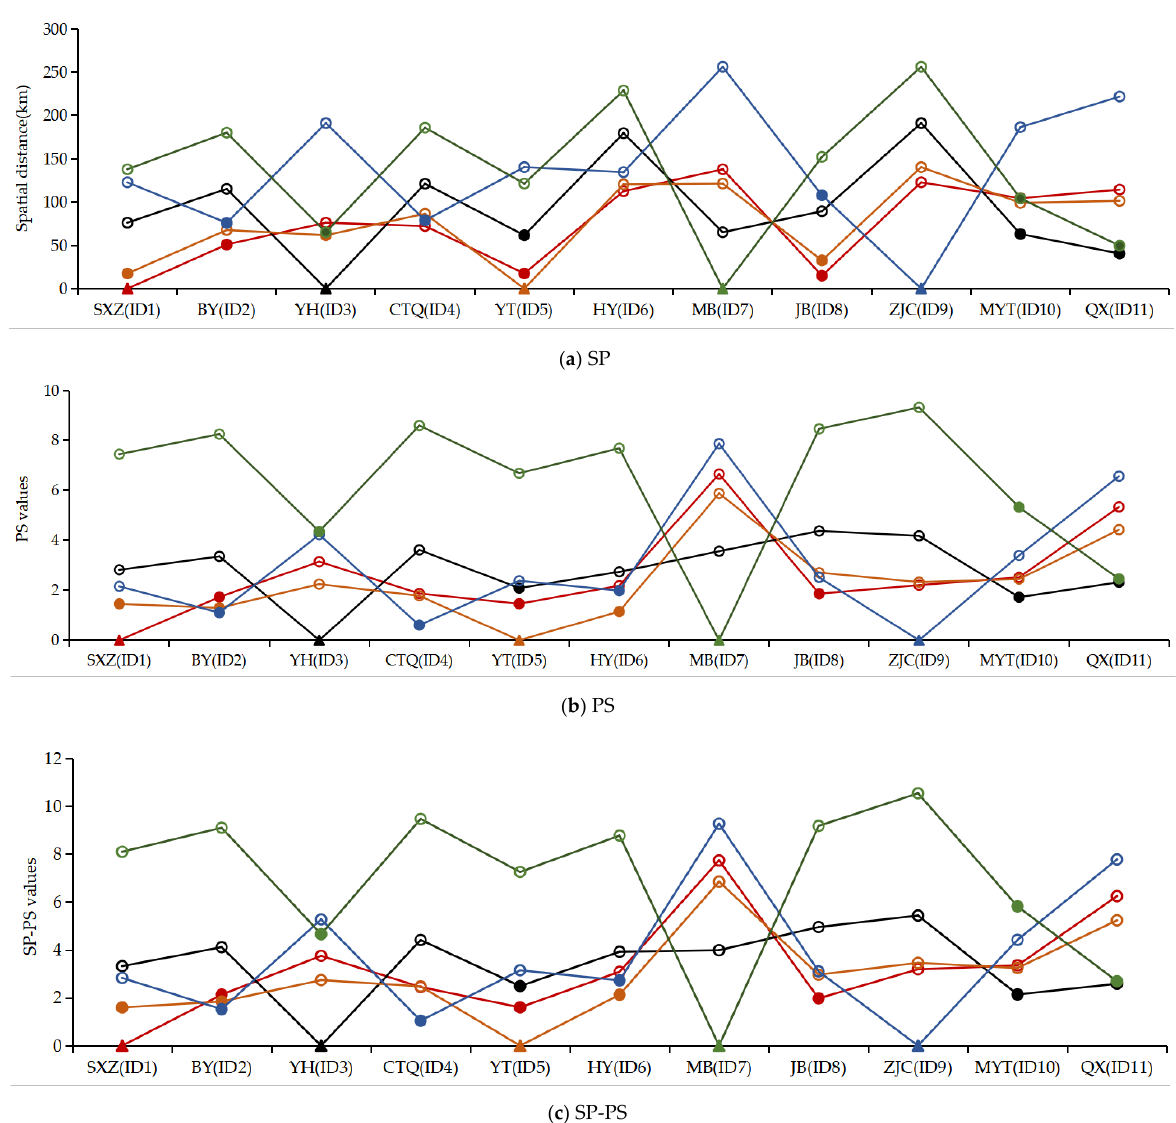
Figure 4. Similarity value between reference basin and target basin calculated by ( a ) SP; ( b ) PS; ( c ) SP-PS approach. The ordinates of ( a – c ) represent the spatial distance (km) of the center of mass, the physical similarity value, and the integration similarity value between the reference basin and the target basin, respectively. The horizontal axis is the 11 study basins: the solid triangle represents the target basin. The solid circle reflects the three most similar reference basins selected for the corresponding target basin. Table 6. Reference basins selected for each ungauged basin and their corresponding similarity values based on SP, PS, and SP-PS.